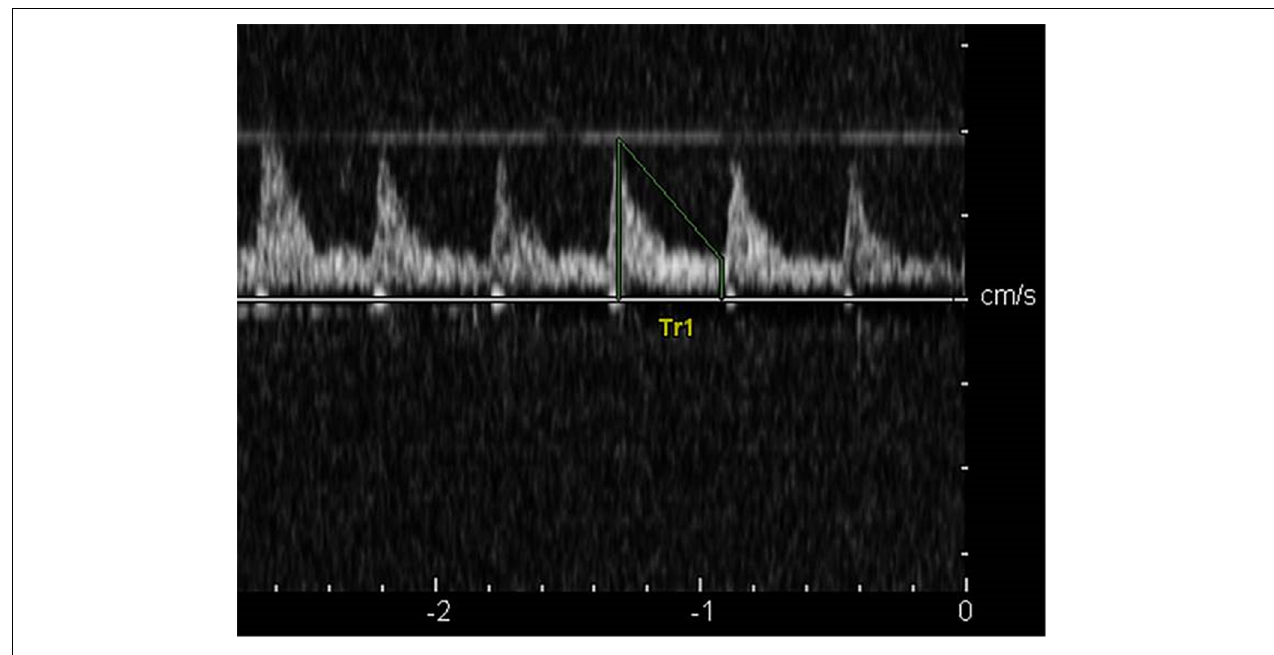
FIGURE 2 | The cerebral blood flow spectrum in the control group.